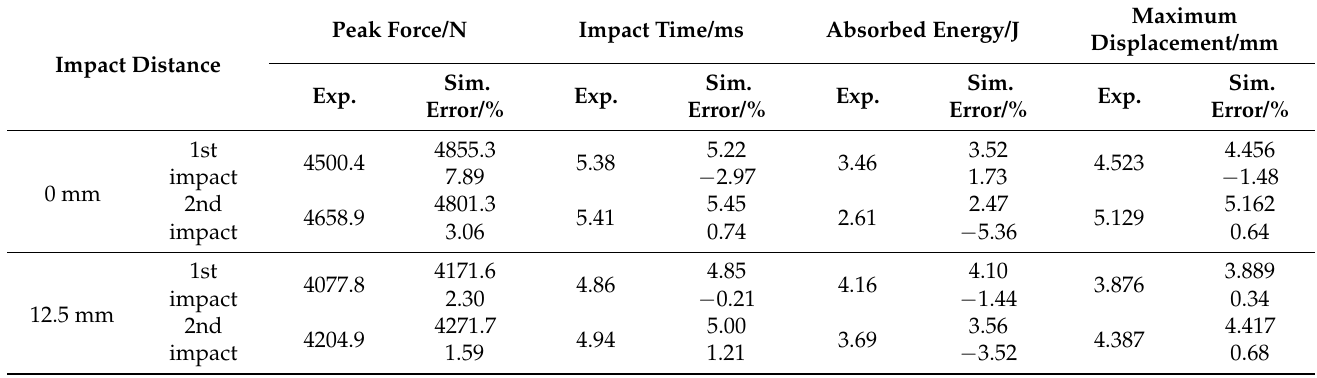
Table 3. Comparisons of impact parameters at impact distances of 0 mm and 12.5 mm (“-” indicate